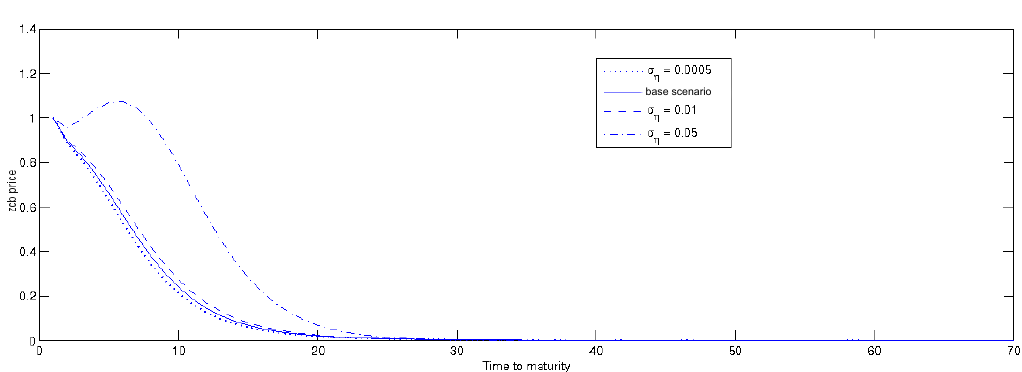
Figure 4. Zero coupon bond price in different hypothesis of known-unknown uncertainty volatility.